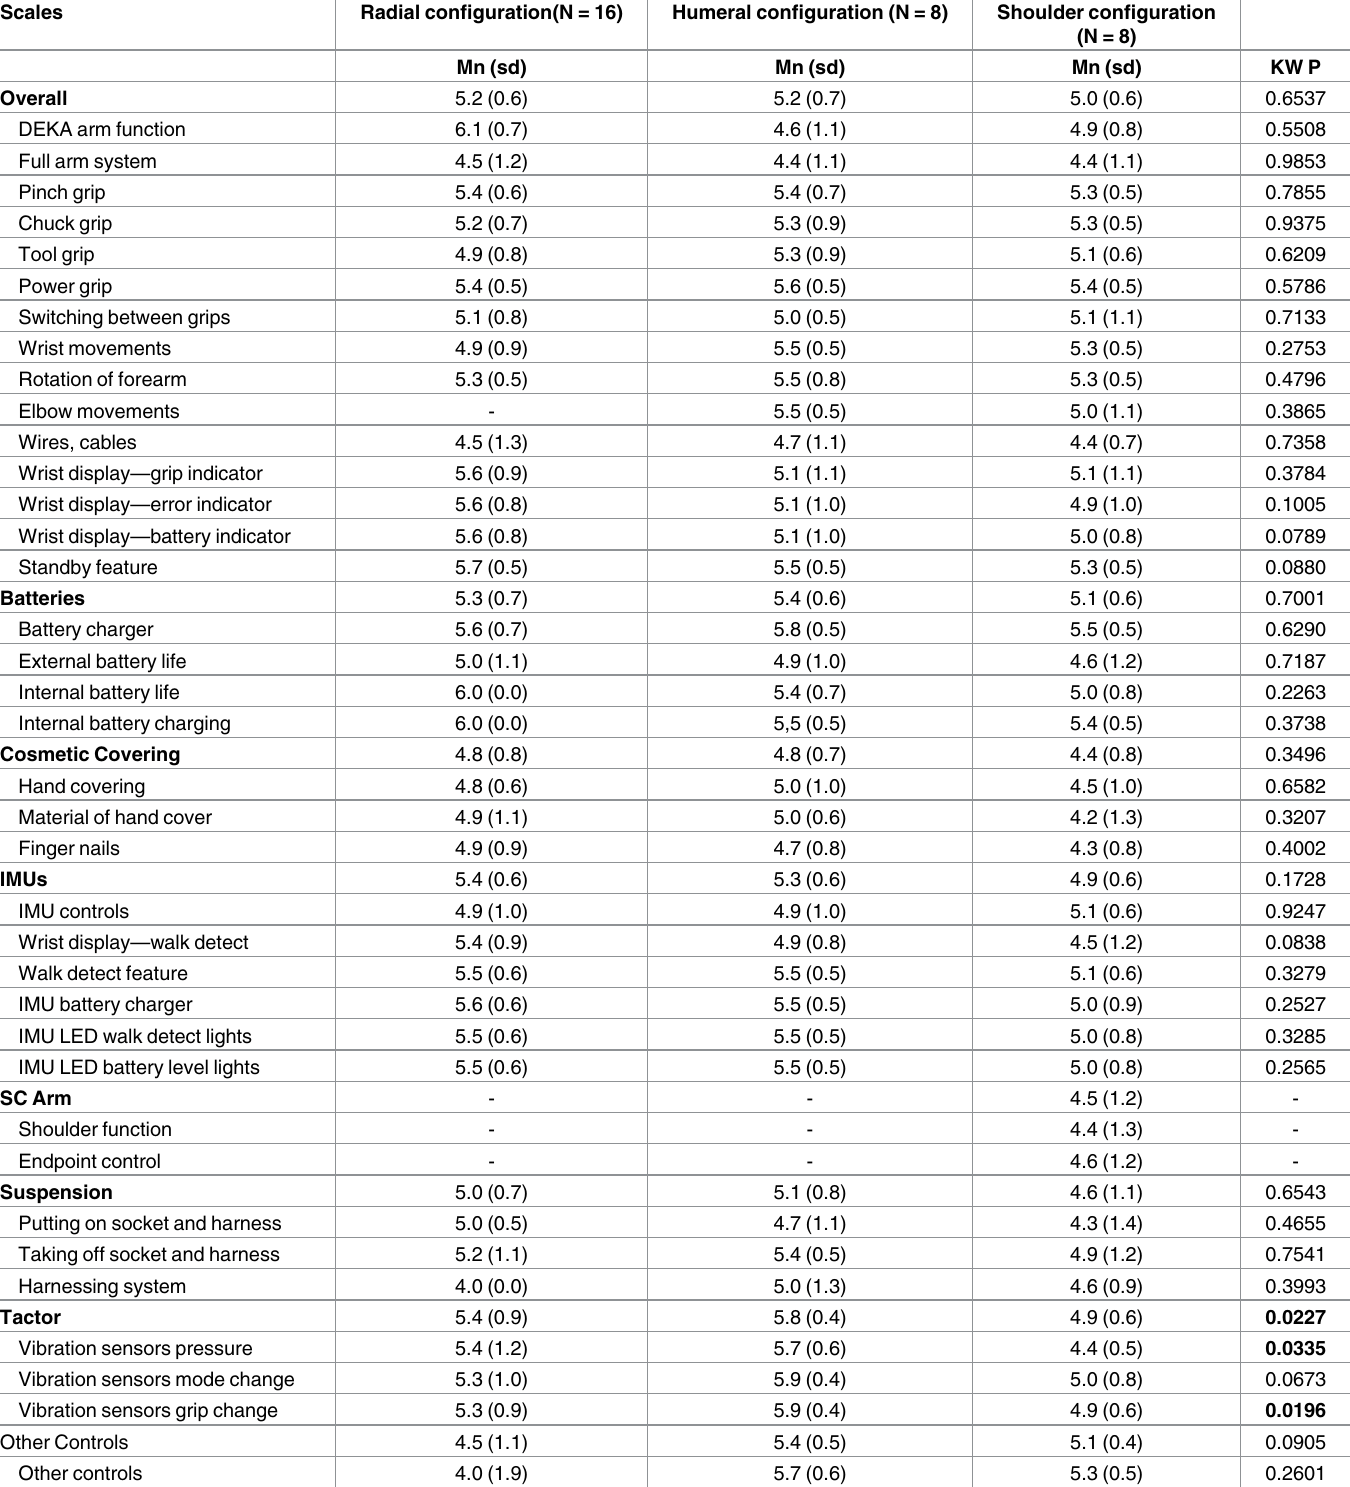
Table 7. Usability ratings by level of DEKA Arm configuration